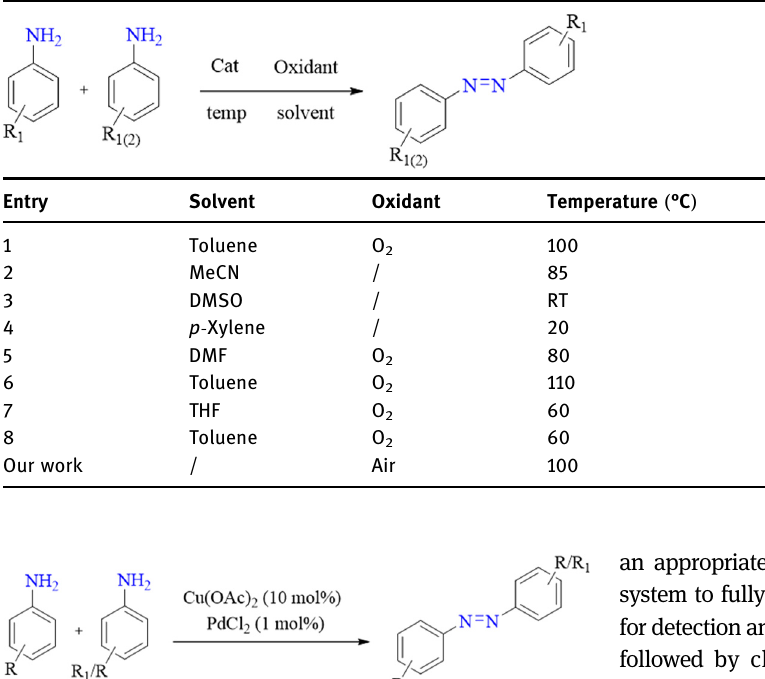
Table 1: Catalytic protocols for the direct synthesis of aromatic azo compounds from anilines